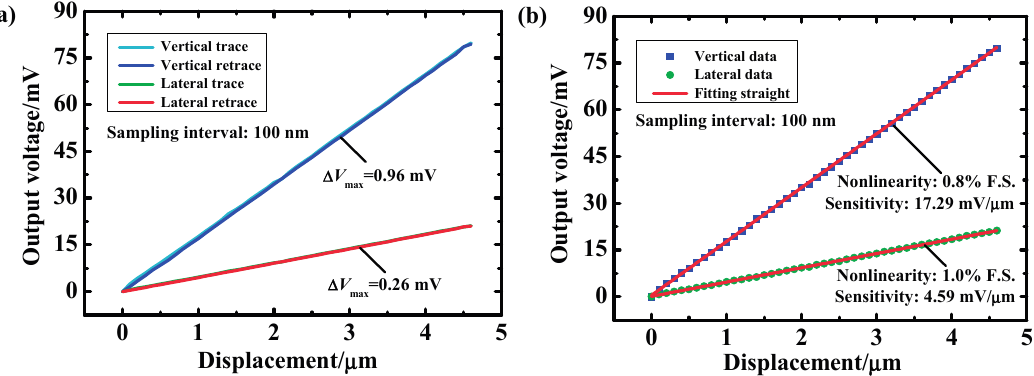
Figure 9. Hysteresis and linearity test. ( a ) Hysteresis test; ( b ) Linearity test.